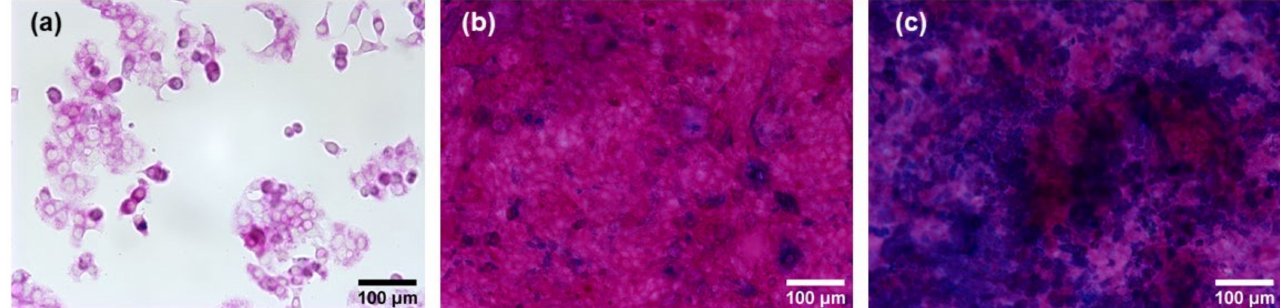
Figure 2. Alcian blue staining and PAS reaction on pre-confluent and confluent E12 cells. The cells were grown for two days ( a ), 11 days ( b ), and 22 days ( c ) post-seeding. Alcian blue was applied to assess acidic mucus. The PAS reaction yielded a pink color on neutral mucus. Images were acquired at 20 ×